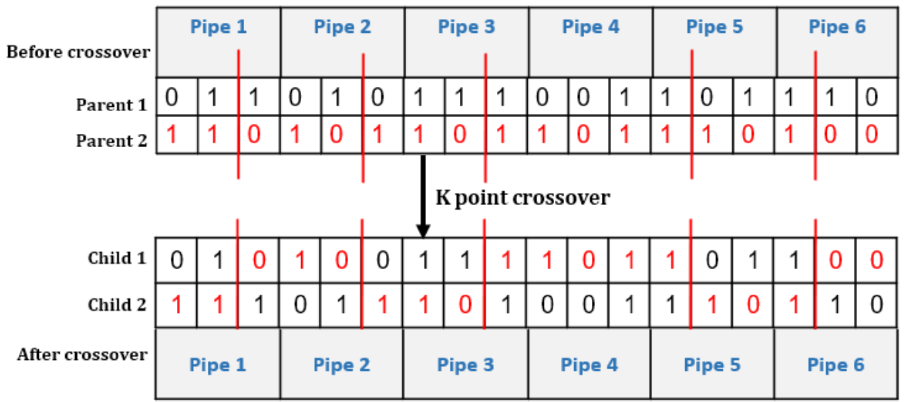
Figure 3. k-point